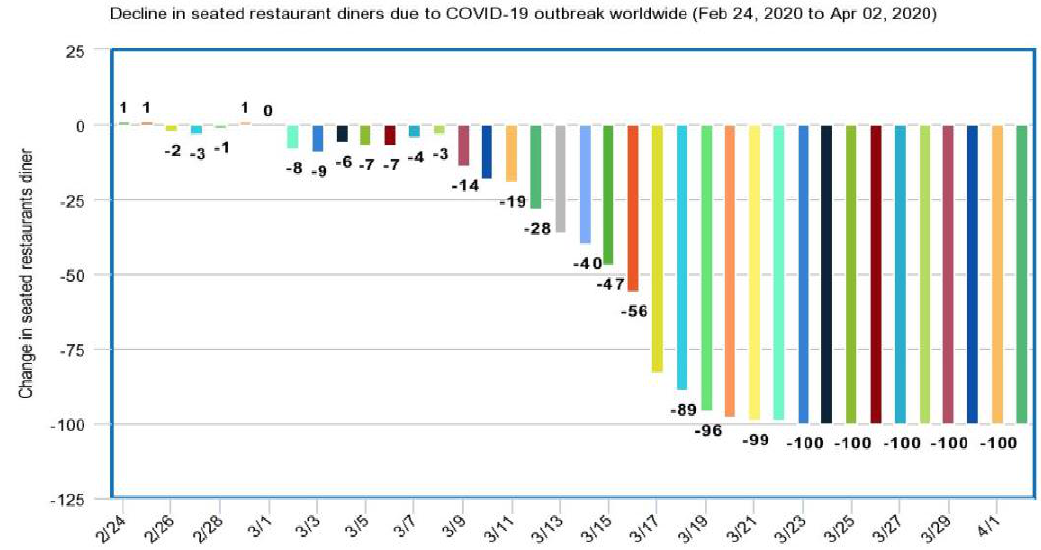
Figure 11. Decline in seated restaurant diners due to the COVID-19 outbreak worldwide.